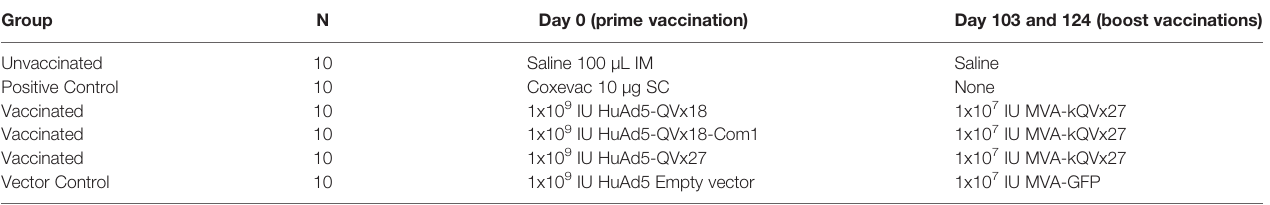
TABLE 2 | Vaccination groups and schedule for C57BL/6 vaccine ef fi cacy study. Group